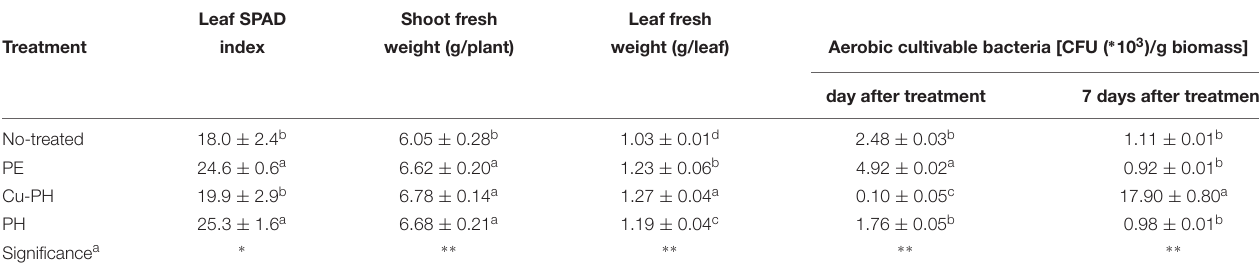
TABLE 2 | Crop parameters and cultivable epiphytic bacteria from lettuce plants treated and no treated with the three commercial